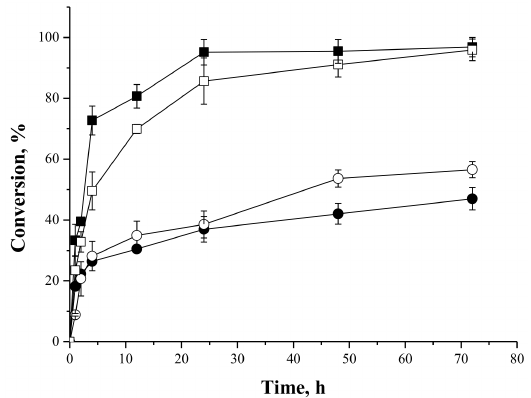
Figure 9. Oleic acid conversion as function of time for syntheses of fructose oleate using tert -butyl alcohol as solvent, 72 h reaction, 250 rpm stirring, oleic acid initial concentration 25 mM, fructose initial concentration 25 mM, using PFL-octyl-silica at 45 ◦ C ( ), PFL-octyl-silica at 55 ◦ C ( ) and oleic acid (cid:35) initial concentration 25 mM, fructose initial concentration 50 mM, using IMMCALB-T2-350 at 45 ◦ C ( (cid:3) ) and 55 ◦ C ( (cid:4) ). For all assays 0.5 g of derivative and 1.5 g molecular sieves were used.